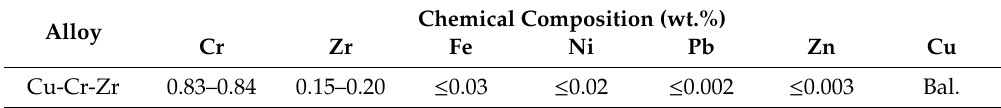
Table 1. Actual chemical composition of the Cu-Cr-Zr alloy. Chemical Composition (wt.%) Alloy